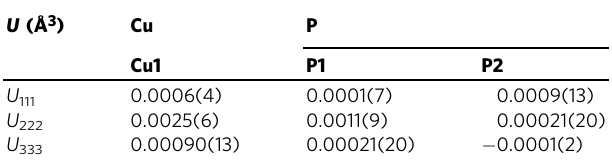
Table 1 Third-order Debye – Waller factors of Cu and P atoms determined in re fi nements of single-crystal X-ray diffraction